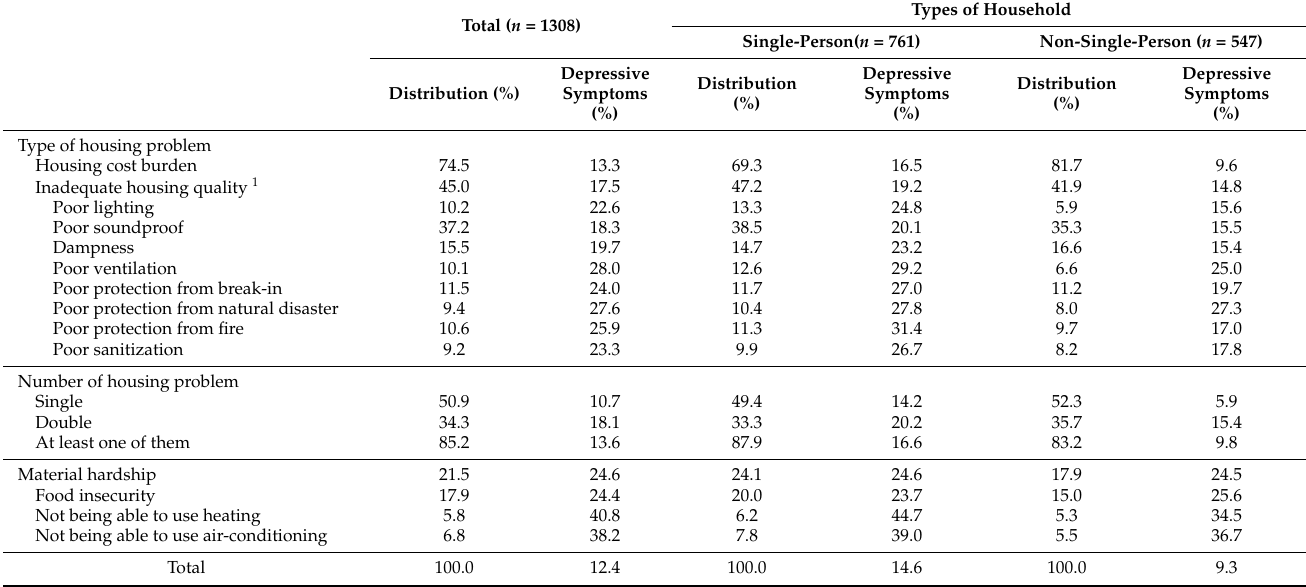
Table 1. Descriptive statistics of the study population.